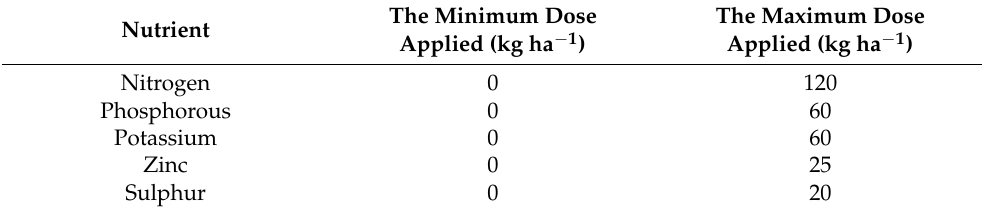
Table 6. The number of neurons in hidden layer 1 and the precision of the models.